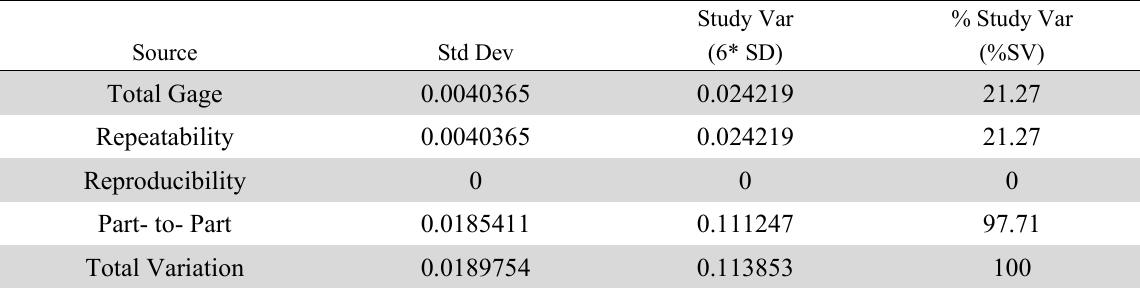
Result of Gauge R & R (Pin Length) for Micrometer